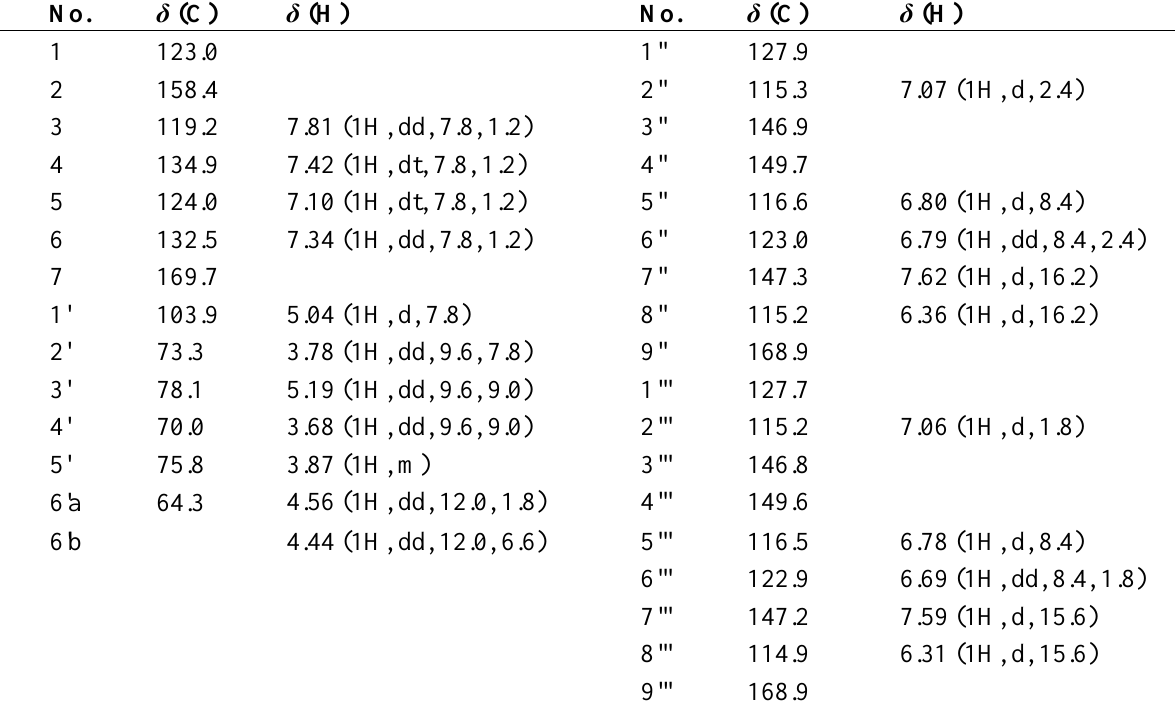
Table 1. 1 H- and 13 C-NMR spectral data of compound 1